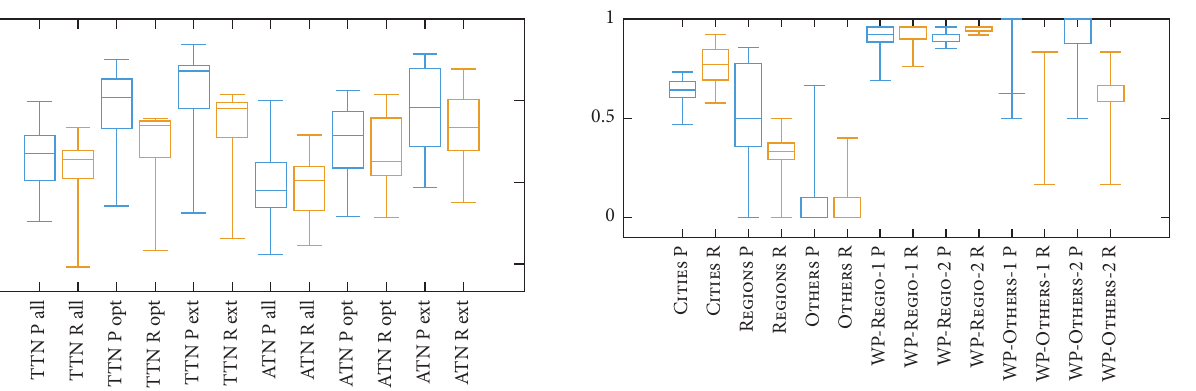
Figure 19: Boxplots of precision (P) and recall ( R ) values ( y -axis) induced by the measures of Table 5 underlying the F -scores of Table 6. Distributions are distinguished by the respective target class of the classification.